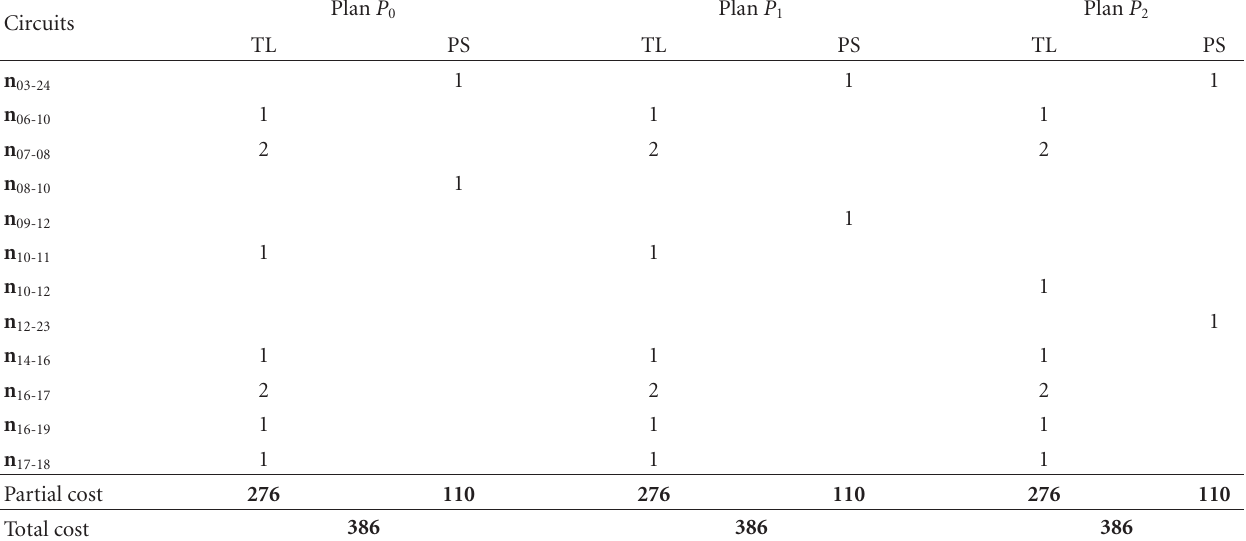
Table 5: Plan P 1 of the system IEEE-24bus considering intermediary-cost phase-shifter transformers.